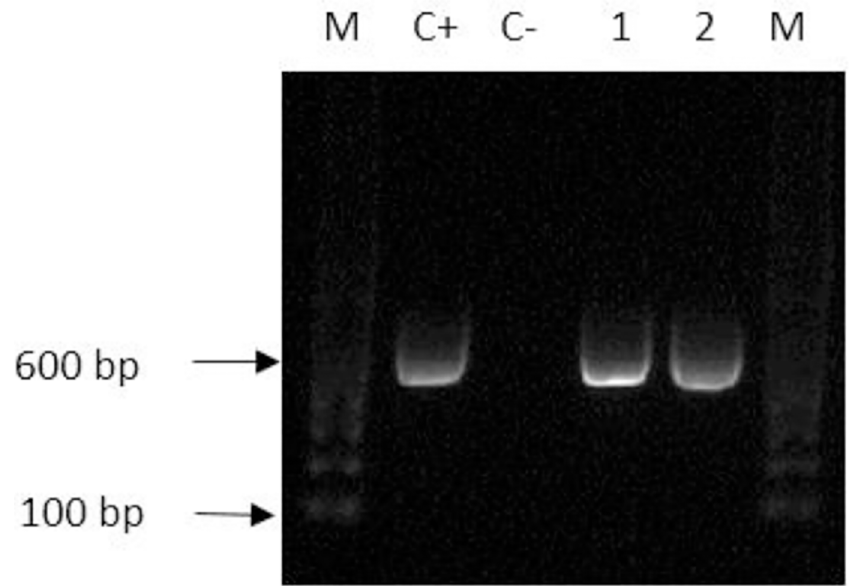
Fig 5. Gel picture of PCR (16S rRNA) of mycobacteria isolated from field samples. M, 100 bp molecular DNA marker; C+ positive control ( M . avium subsp. avium ATCC 15769), C- negative control (sterile water); 1 and 2 (564 bp) positive samples from